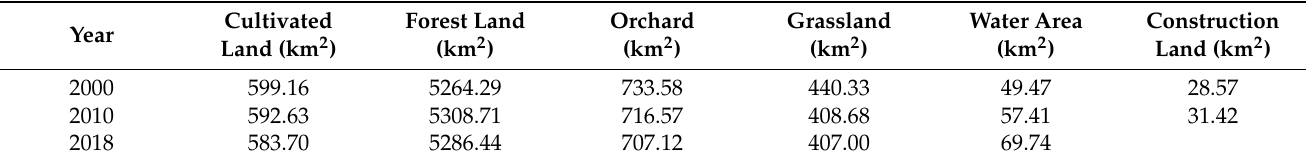
Figure 2. Land-use change in the CMA from 2000 to 2018. ( a ) 2000, ( b ) 2010, ( c ) 2018.